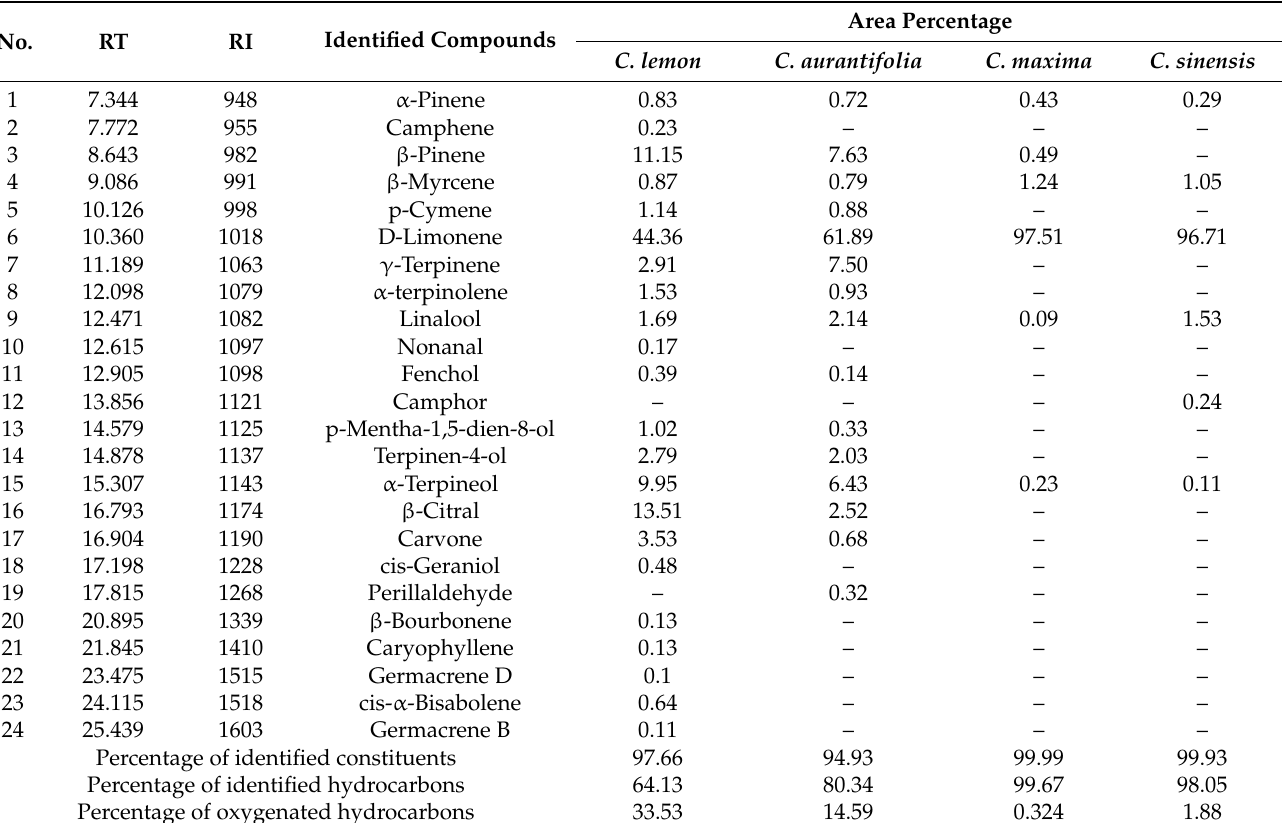
Table 1. Essential oil composition of C. lemon , C. aurantifolia , C. maxima , and C. sinensis